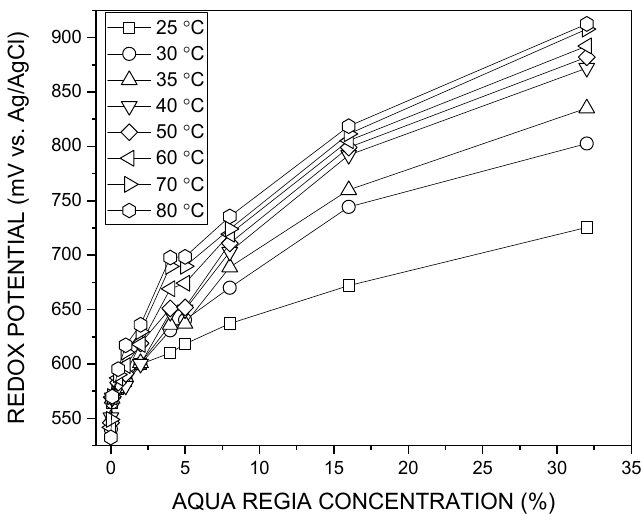
Figure 2. The redox potential of aqua regia solutions at temperatures of 25, 30, 35, 40, 50, 60, 70, and and 80 ◦ C as a function of aqua regia 80 °C as a function of aqua regia concentration.